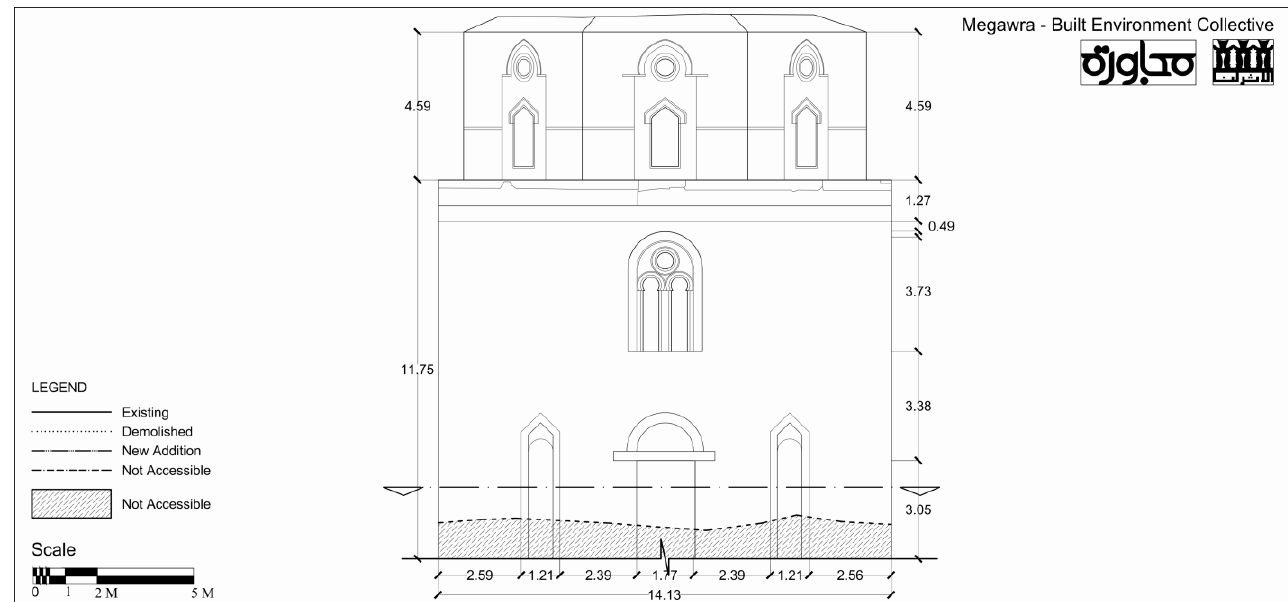
Figure 4. CAD drawing of the north-west elevation of the dome of Fatima Khatun (Reproduced with permission from MEGAWRA-BEC, unpublished report, 2017 [38]).